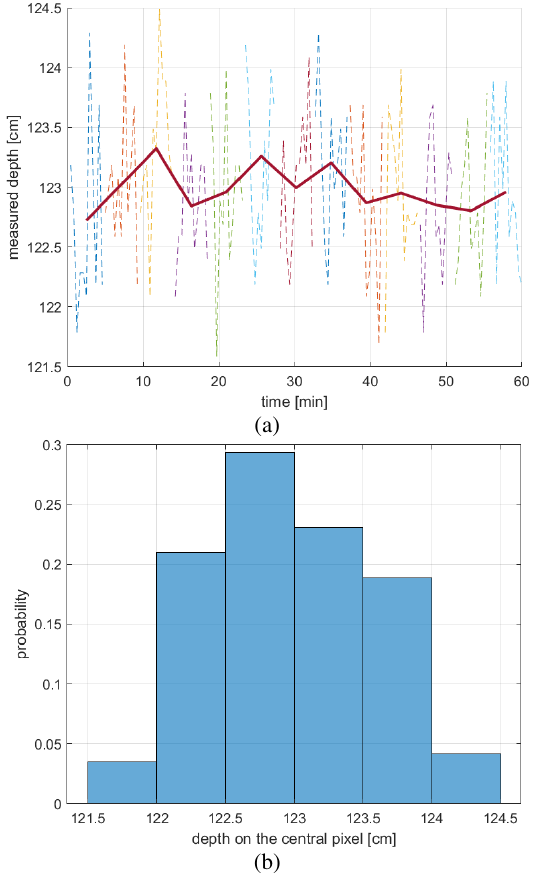
Figure 5. (a) Values of the depths on the sensor center over one hour (dashed line). Average of the depths collected in different sequences is shown in bold solid line. (b) Distribution of the values of the depths on the sensor center shown in (a). The variation among such averaged values apparently tends to converge approximately after 40 minutes.